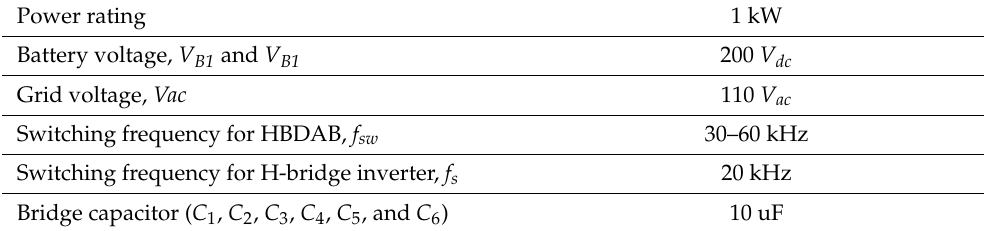
Table 1. Ratings and circuit parameters for the prototype converter.